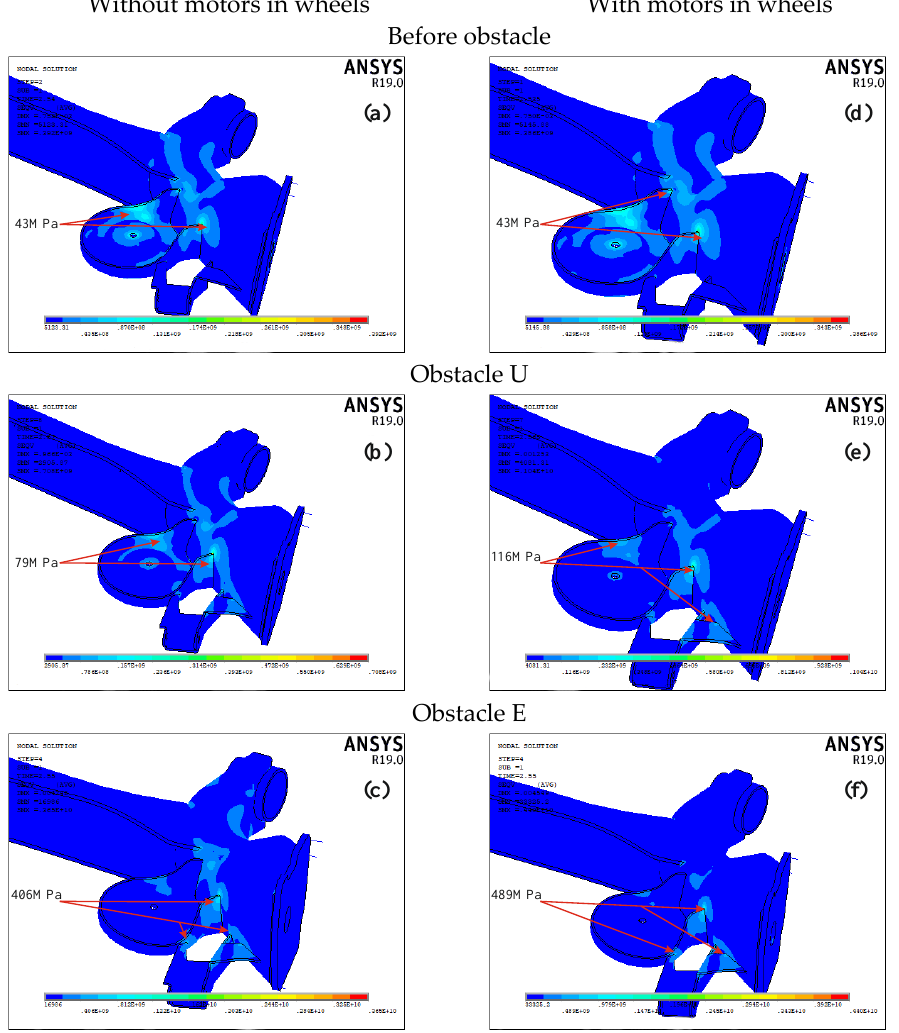
Figure 17. Contour plot of the reduced stresses obtained during overcoming an obstacle at velocity υ = 60 kmh − 1 . ( a ) without motors in wheels and before obstactle, ( b ) without motors in wheels and obstactle U, ( c ) without motors in wheels and obstactle E, ( d ) with motors in wheels and before obstactle, ( e ) with motors in wheels and obstactle U, ( f ) with motors in wheels and obstactle E.